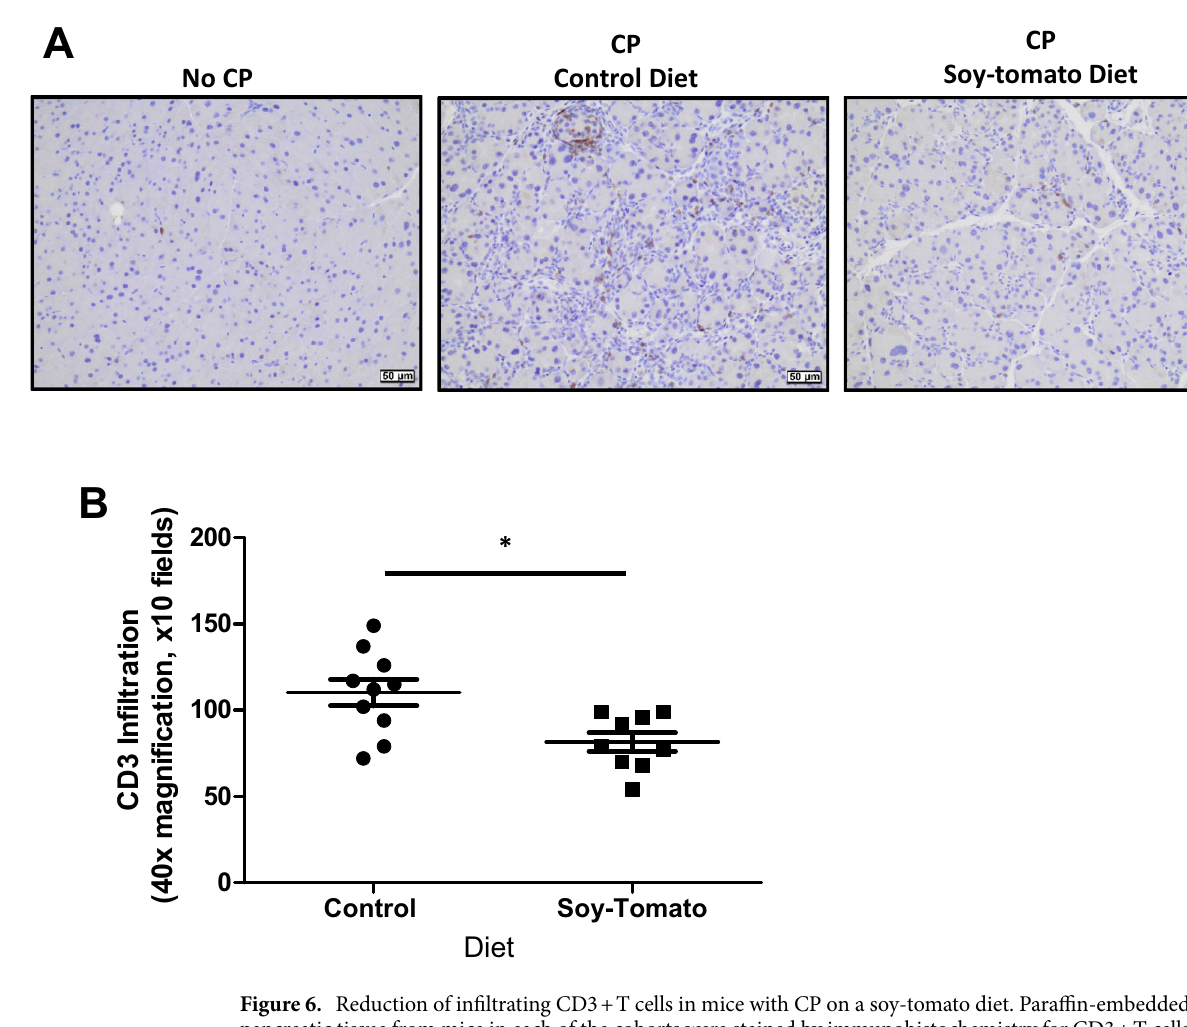
Figure 6. Reduction of infiltrating CD3 + T cells in mice with CP on a soy-tomato diet. Paraffin-embedded pancreatic tissue from mice in each of the cohorts were stained by immunohistochemistry for CD3 + T cells (Brown). ( A ) Tissue sections were imaged at 40× magnification and ( B ) immunopositive cells were quantified from 10 random fields (n =